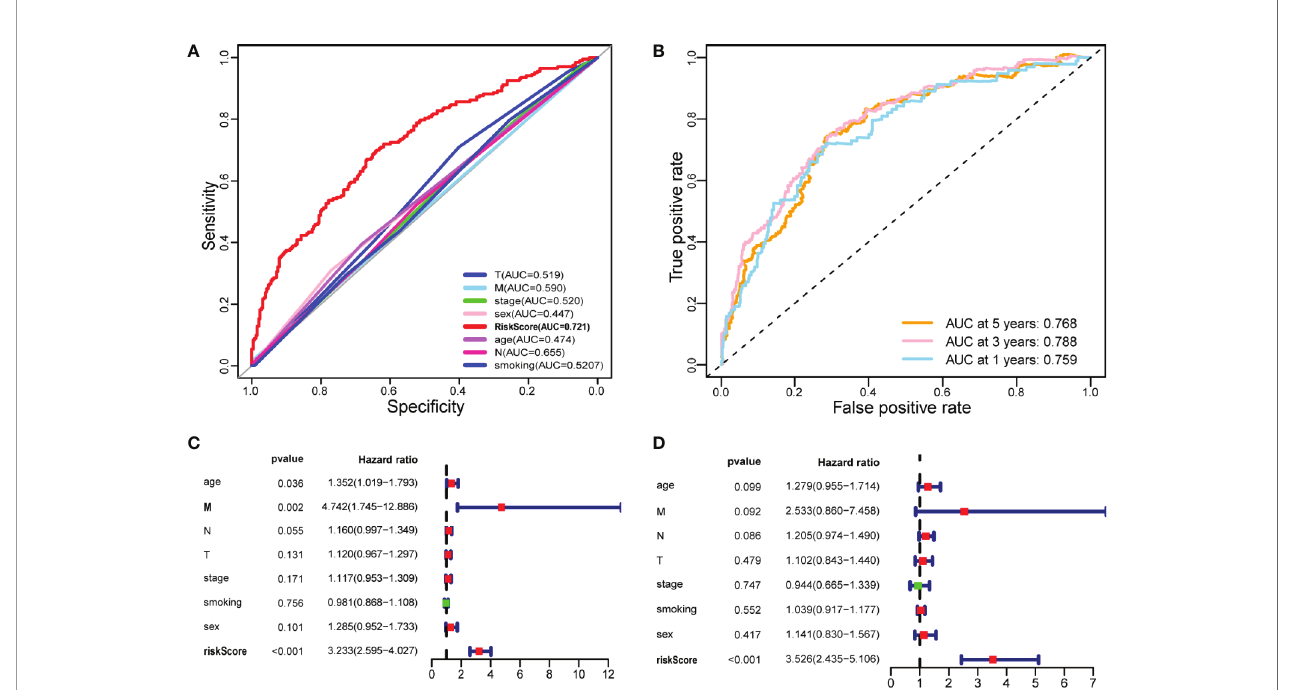
FIGURE 3 | Evaluate the predictive ability of the IRLPs signature. (A) A comparison of ROC curves with other common clinical characteristics showed the superiority of the IRLPs signature. (B) The 1-, 3-, and 5-year ROC curve of the optimal model suggested that all AUC values were over 0.75. (C) Forest plot of univariate